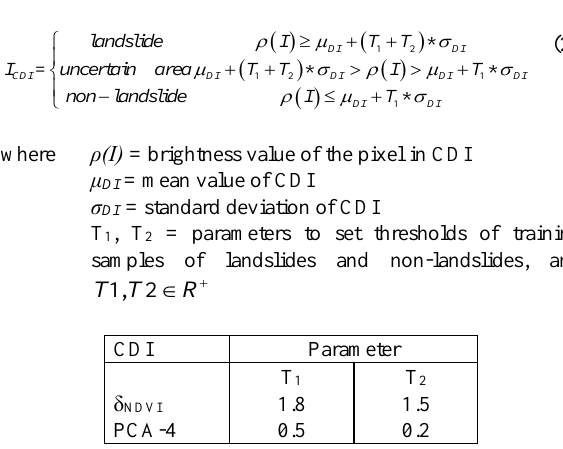
Table 1. Parameters of multi-threshold